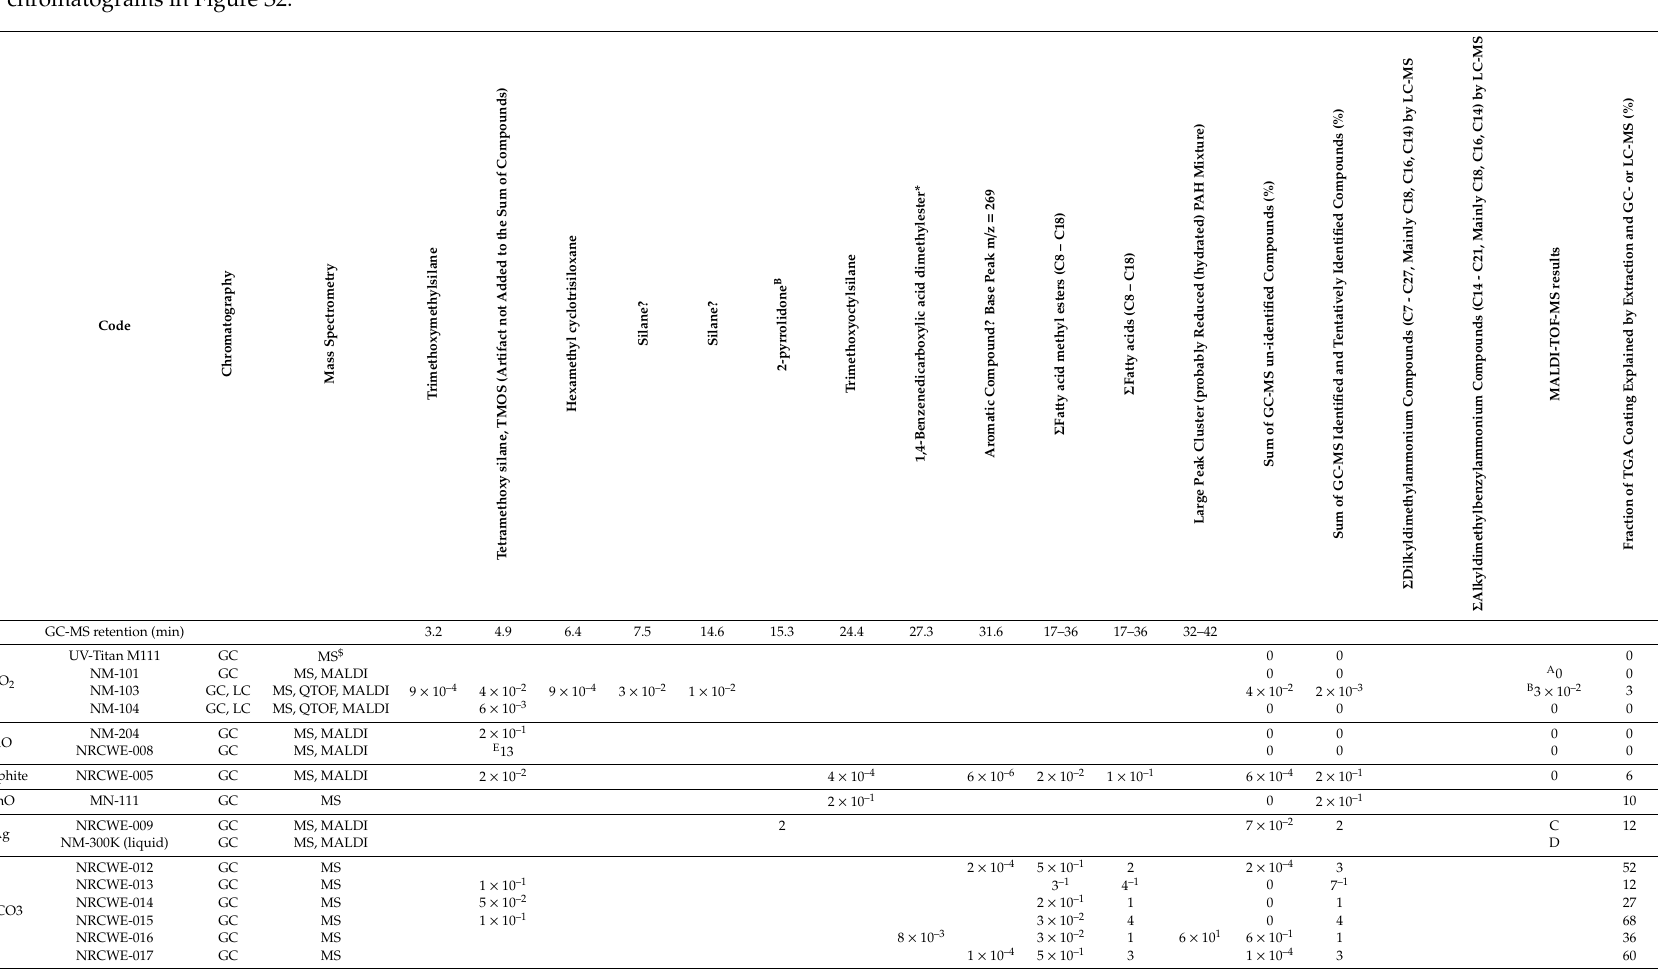
Table 3. Identified and unidentified major organic compounds and groups associated with the MNMs in Table 2 given as semi-quantitative % (w / w) of MNM mass. A number of un-identified GC-MS peaks are not listed but included in “Sum of un-identified compounds”. Un-identified compounds are marked with “?”. Tentatively identified compounds (marked with *) have not been verified by authentic standards. Results on single compound level are shown in Table S2 and illustrative chromatograms in Figure